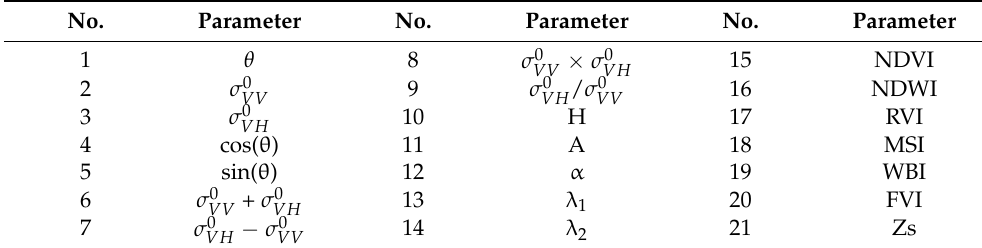
Table 2. Summary of parameters extracted from Sentinel-1 and Sentinel-2